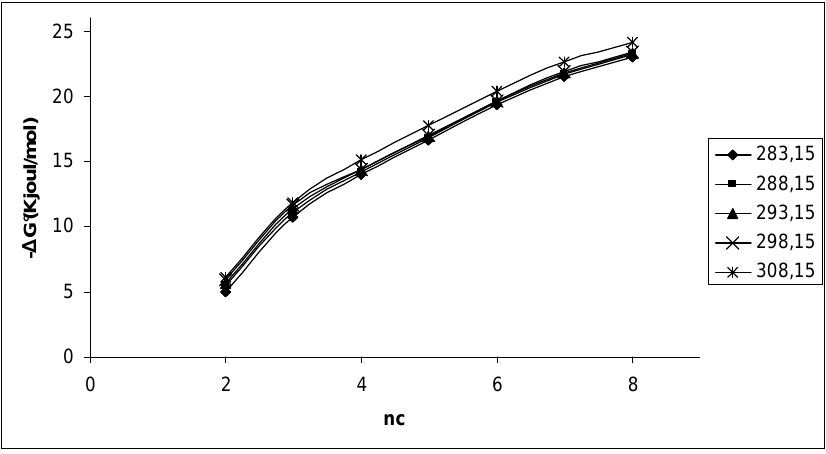
Figure 5. ∆ G° for the binding of alcohols to α -cyclodextrin against the number of carbon atoms, n . c